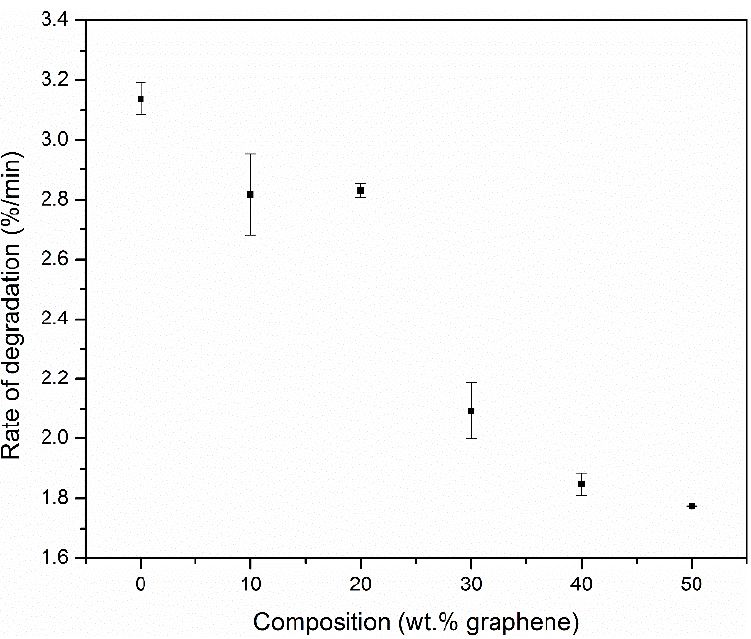
Figure 8. Rate of degradation of the polymer matrix as a function of the percentage of graphene in the nanocomposites (in nitrogen; β = 30 °C/min).